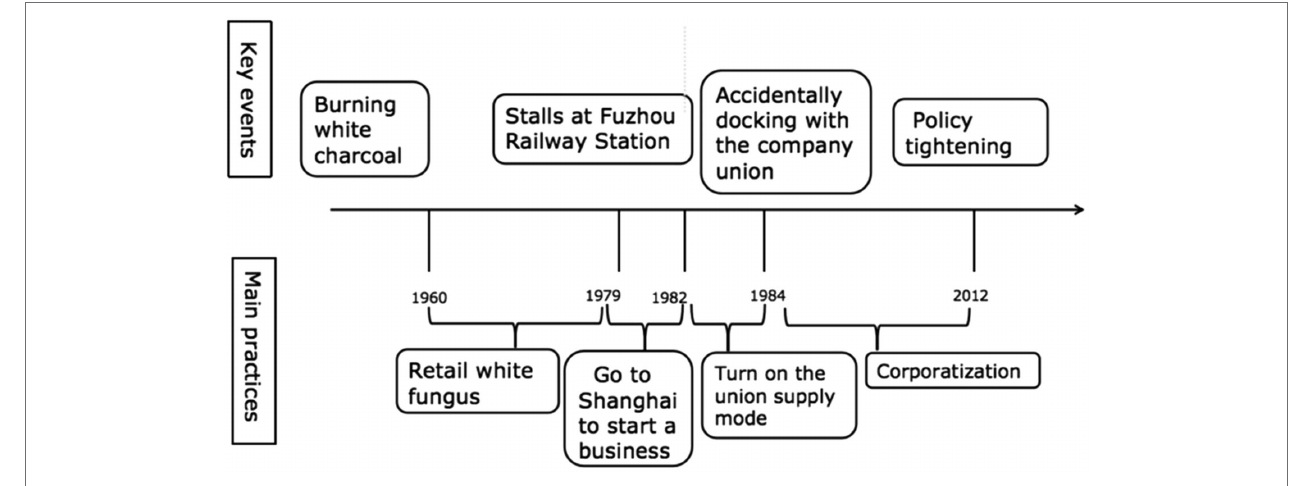
FIGURE 1 | Key events and main practices in Q Village since 1960.